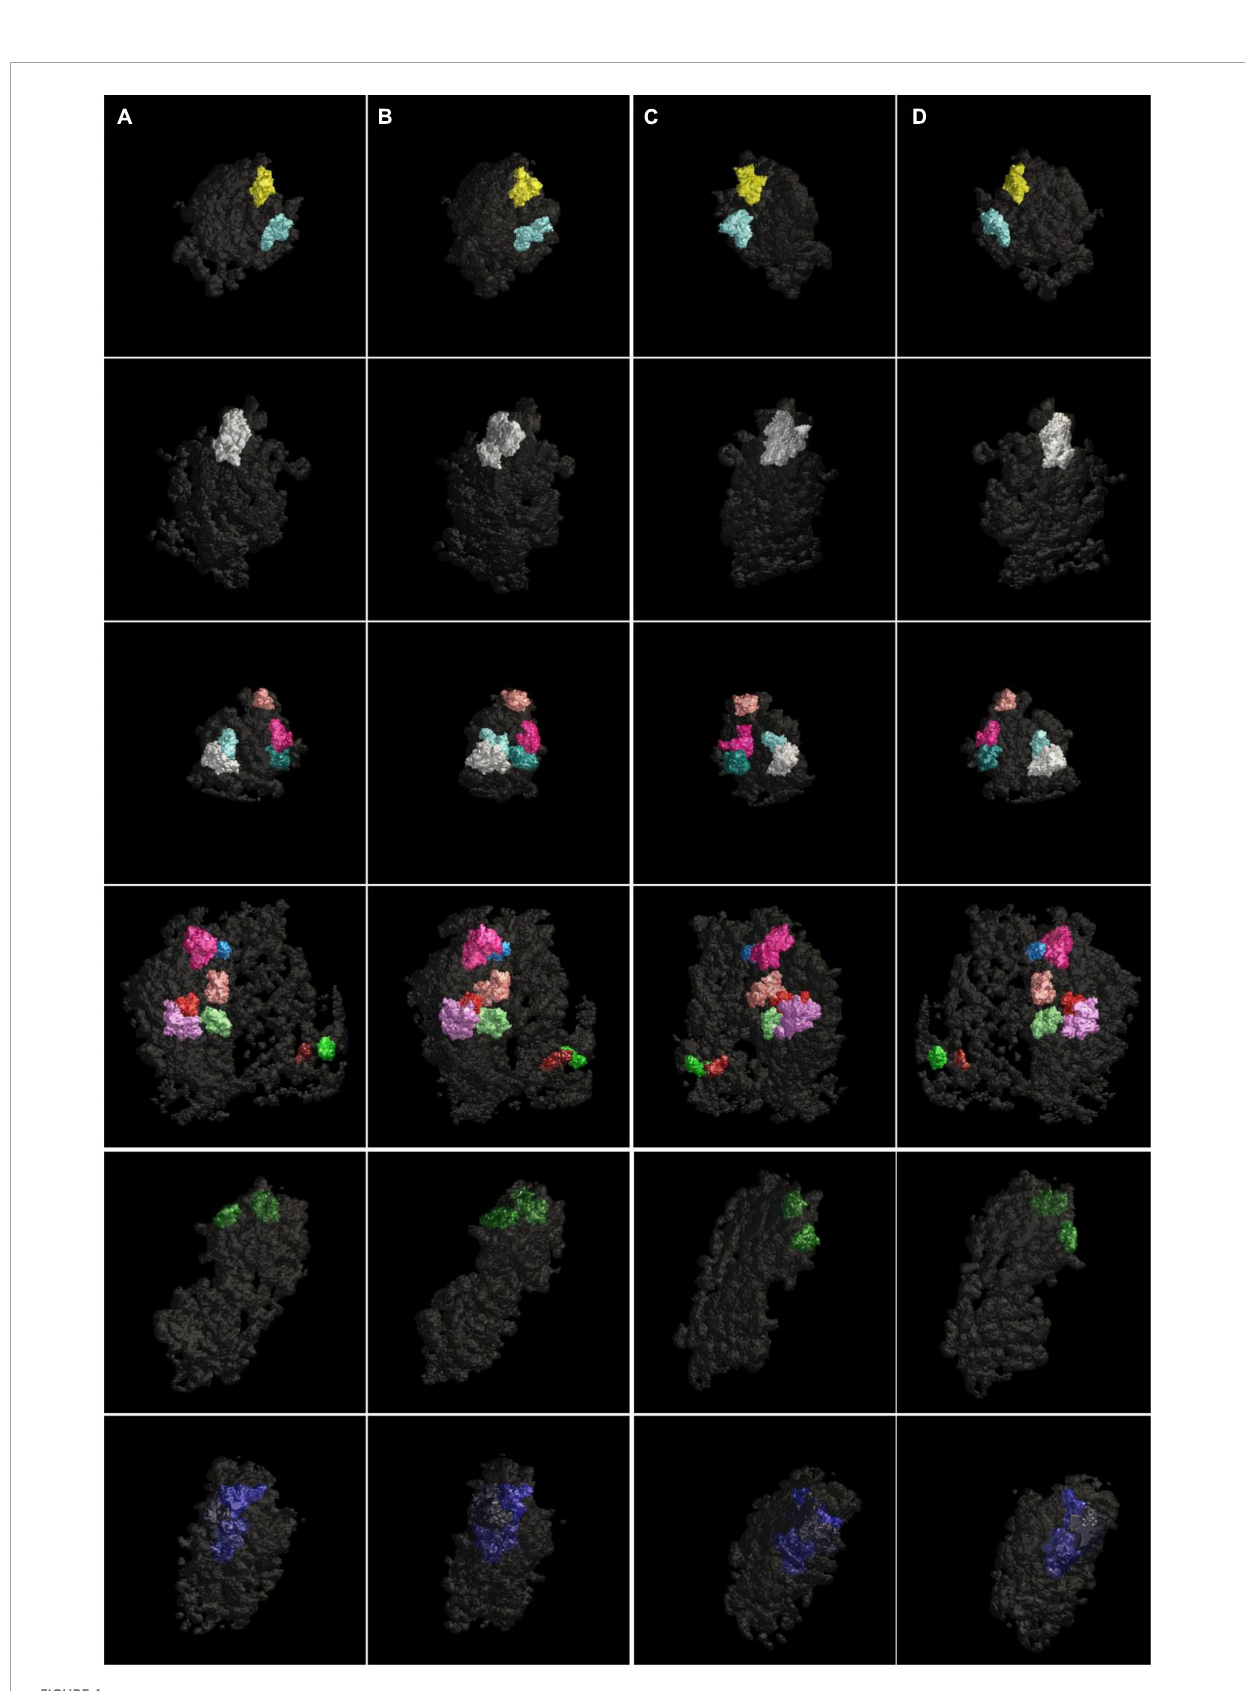
FIGURE4 Surface models of modules spanning the whole thickness of the PSDs ( trans- PSD modules) viewed at four different angles. The trans- PSD modules of four different PSDs were viewed (A) en face , (B) after ∼ 45-degree rotation, (C) ∼ 135-degree rotation, and (D) from behind. The PSDs contained one to eight trans- PSD modules. Each trans- PSD module fell into a range from 6 × 10 4 nm 3 to 5 × 10 5 nm 3 in volume taking up 0.5–6% of the volume of its PSD for control PSDs (four rows from the top) and from 1 × 10 5 nm 3 to 5 × 10 5 nm 3 in volume taking up 1.4–7% for sonicated PSDs (two rows from the